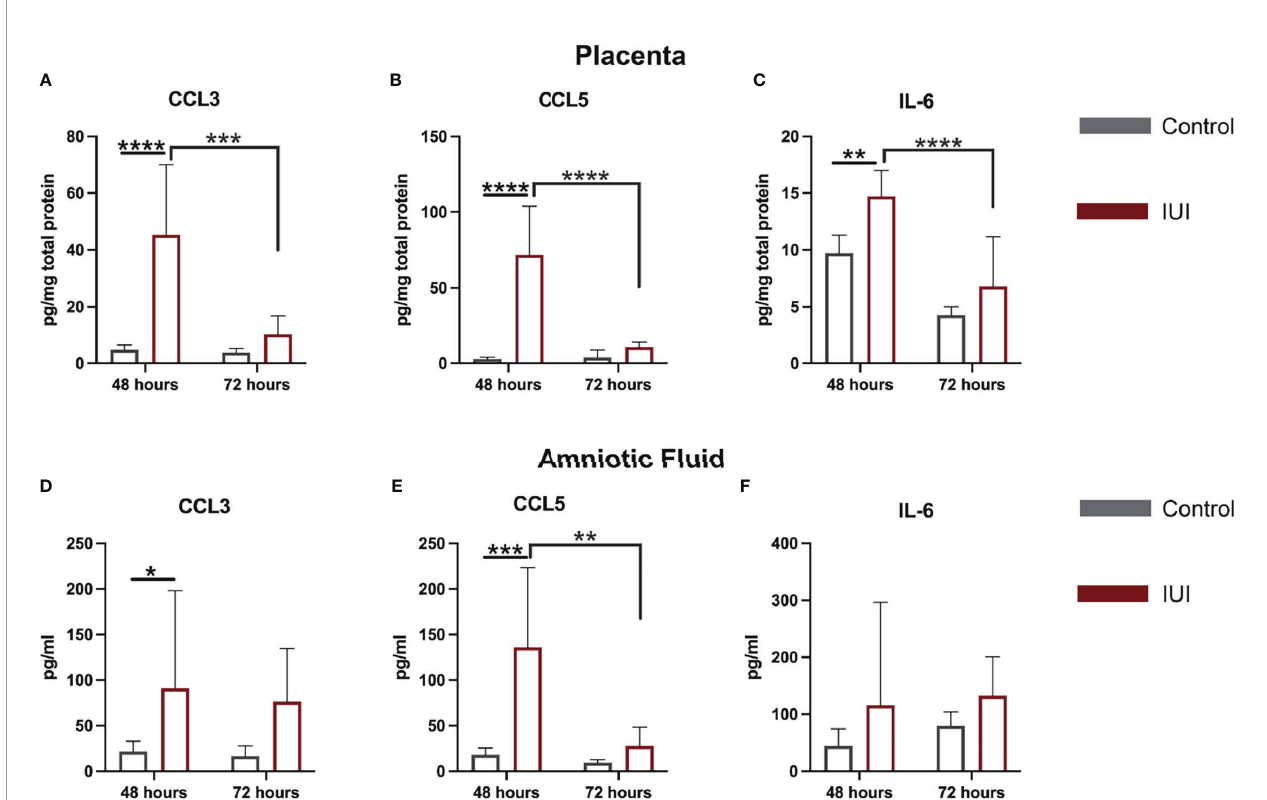
FIGURE 3 | Elevated chemokines found in the placenta and amniotic fl uid following intrauterine in fl ammation. Cytokines were measured in the placenta and amniotic fl uid by ELISA, from samples collected at 48 and 72 hours post-uterine injection. (A – C) Placental ELISA values were normalized to total placental protein measured by BCA, while (D – F) amniotic fl uid ELISA values were normalized to fl uid volume. Signi fi cant differences were determined by two-way ANOVA followed by post-hoc Tukey ’ s multiple comparison test. *p<0.05, **p<0.01, ***p<0.001,